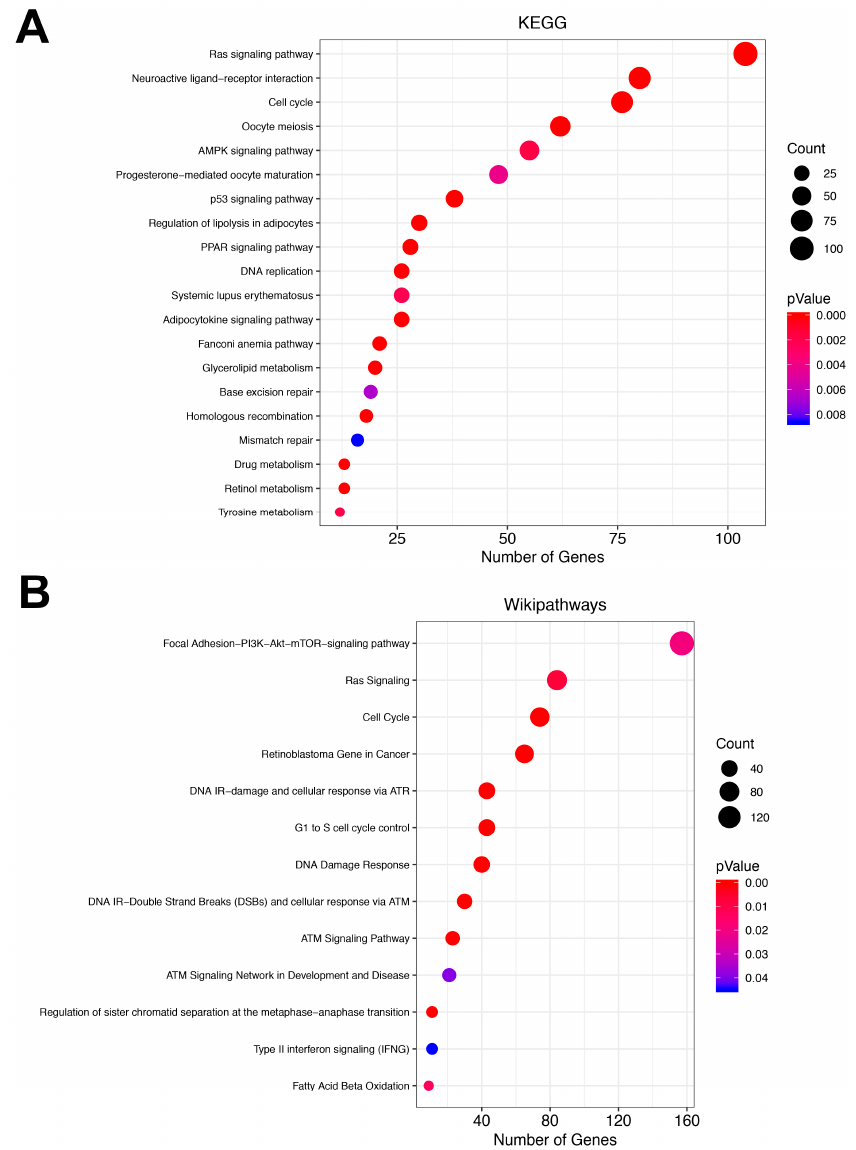
Figure 4. Pathway analysis in the WebGestalt platform. ( A ) Shows the enriched pathways in the KEGG database. The size of the dots depicts the number of genes in the pathway, while the dot color represents the significance of the analysis, where red shows a more significantly enriched